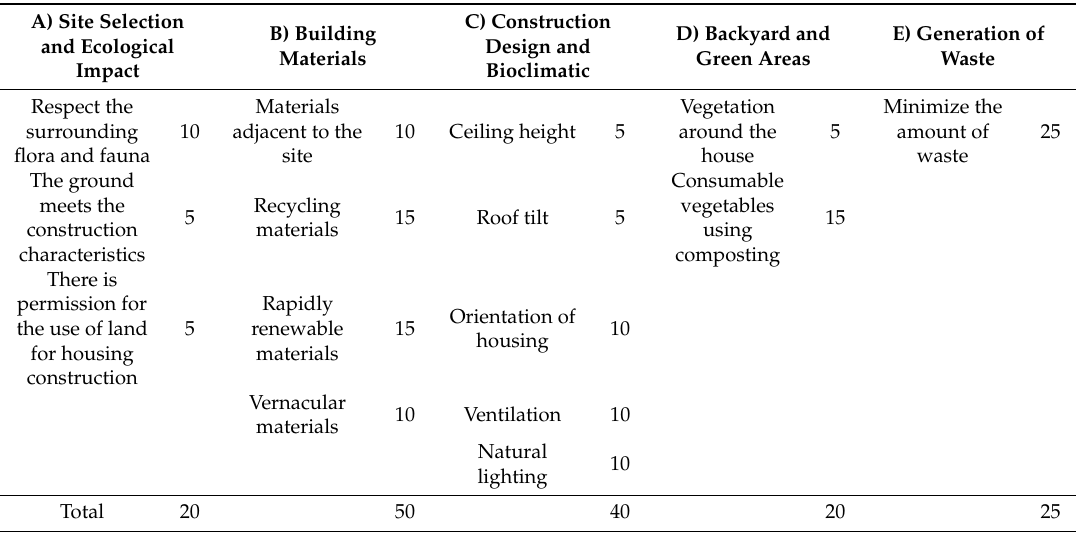
Table 1. The weight for the evaluation of the degree of sustainability for the construction stage of the housing.